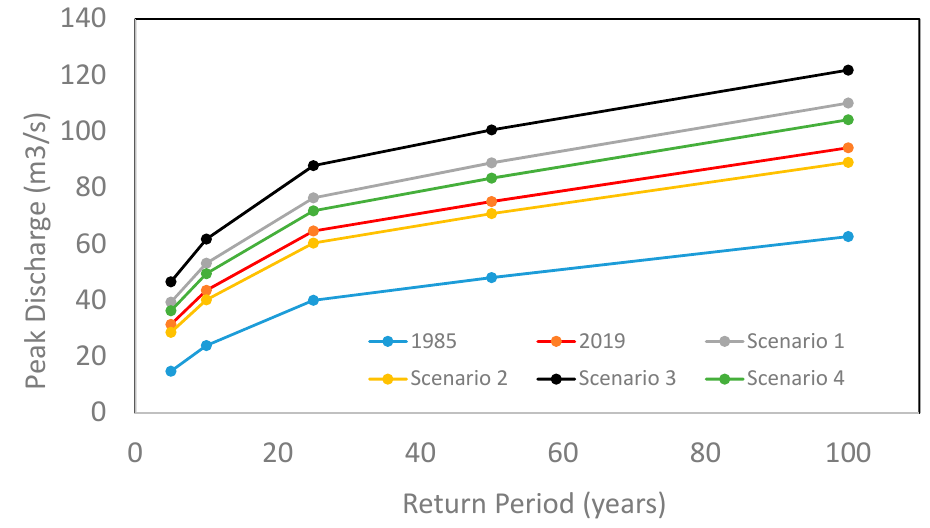
Figure 7. Design peak discharge for Esamburmbur under different LULC scenarios.